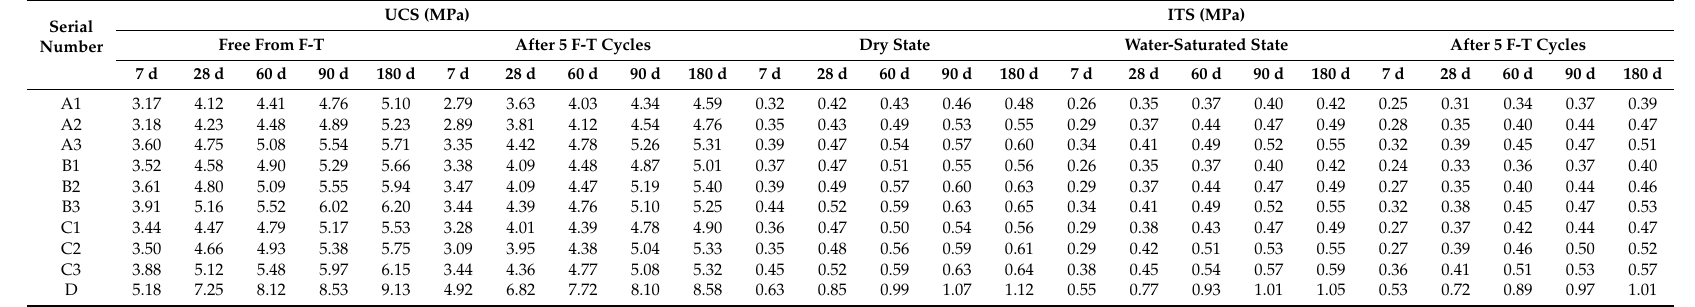
Table 4. The experimental results of the unconfined compressive strength, indirect tensile